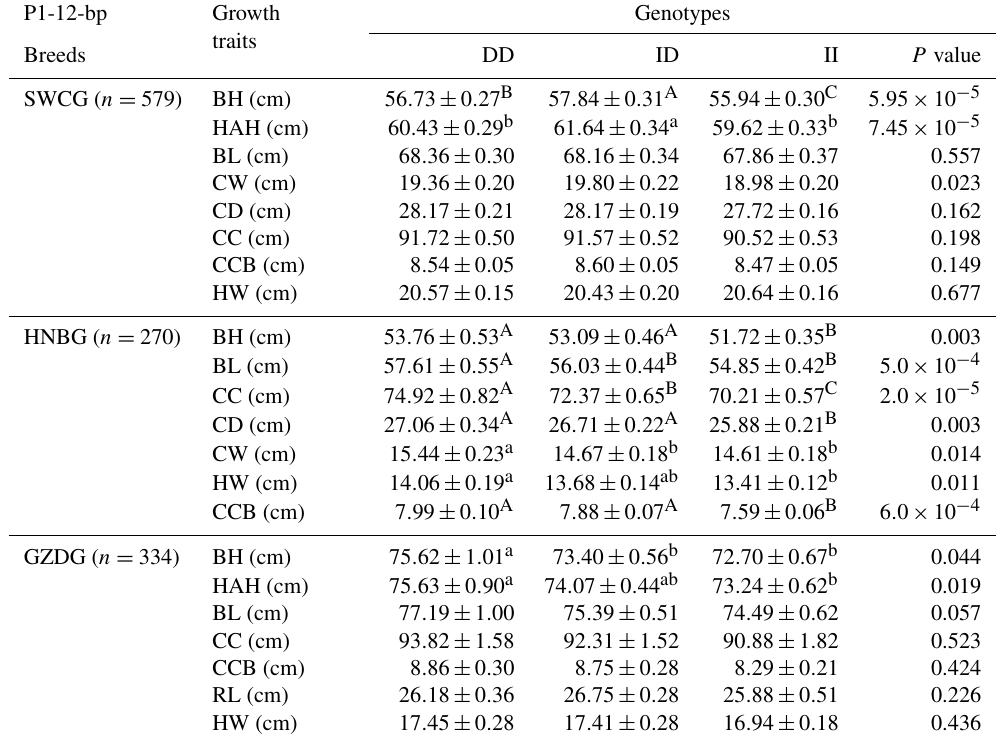
Table 4. Association of the indel within the ATBF1 gene and growth traits of the P1-12-bp indel of three Chinese goat breeds (mean ± SE). P1-12-bp Growth traits